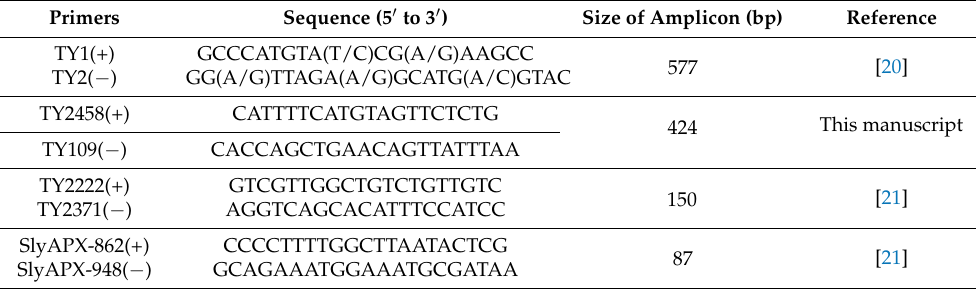
Table 1. List of primers used in this